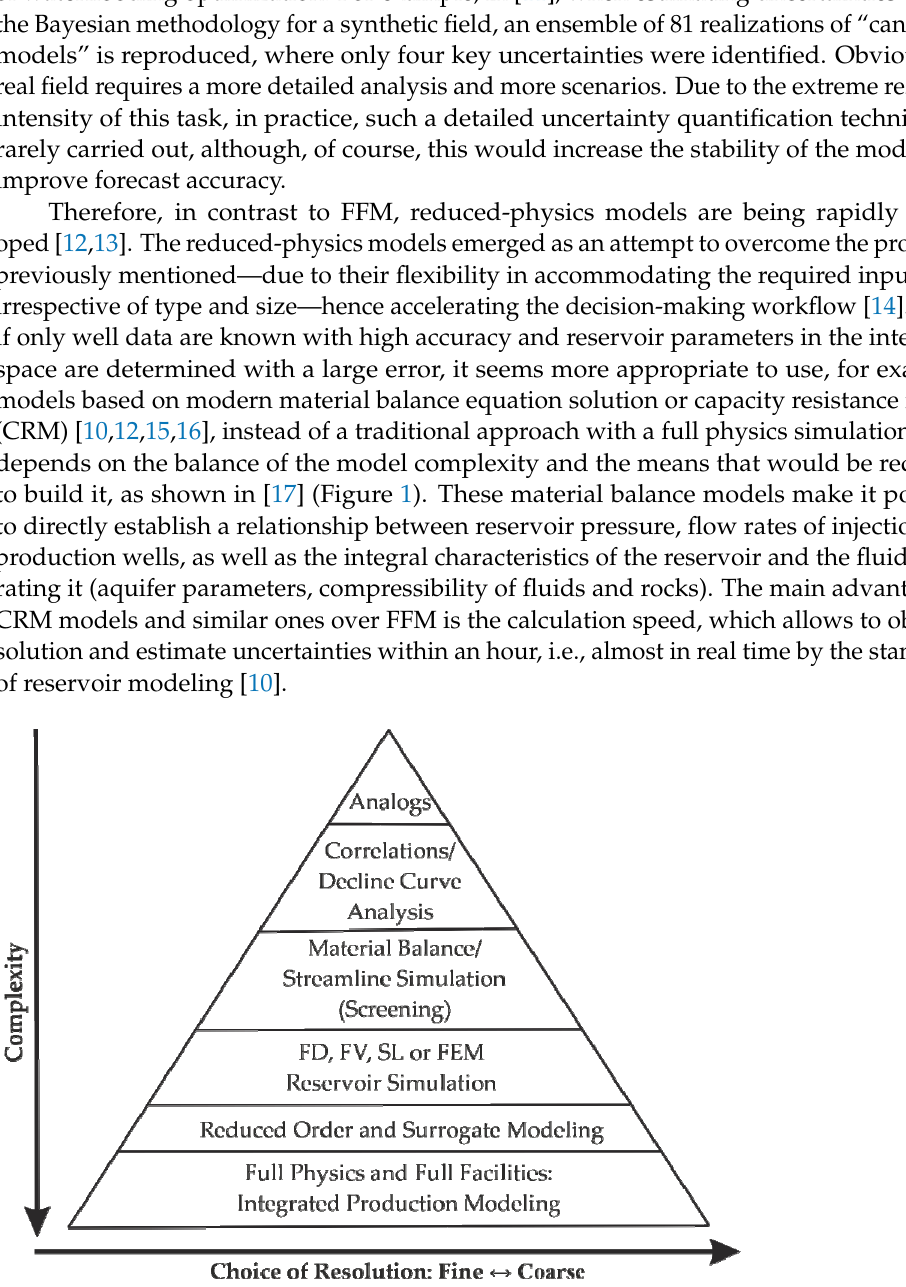
Figure 1. Classification of reservoir model reduction via complexity reduction [17]. Thus, an important task is to choose a model of optimal complexity that would describe the key features of the modeling object with an accuracy sufficient for